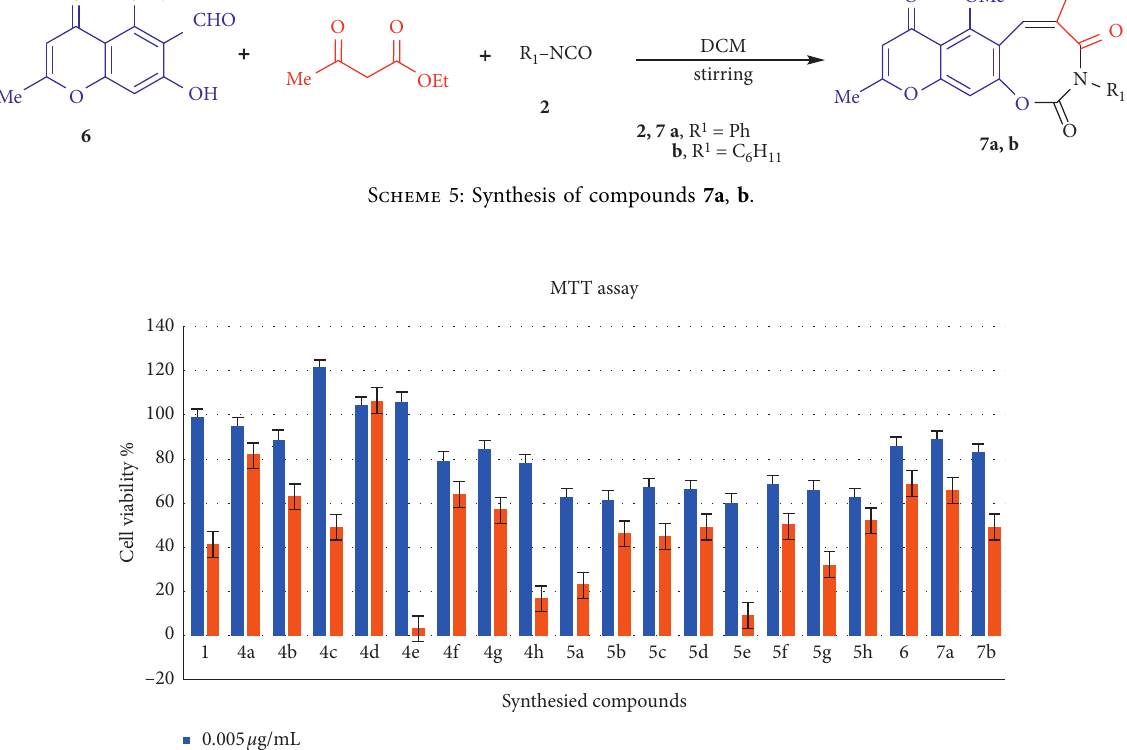
Figure 1: Breast carcinoma cell line (MCF7) cell viability after 48h treatment with the synthesized Table 1: The antiproliferative potency of the newly prepared derivatives toward hepatic and breast cancer cell lines. Compound